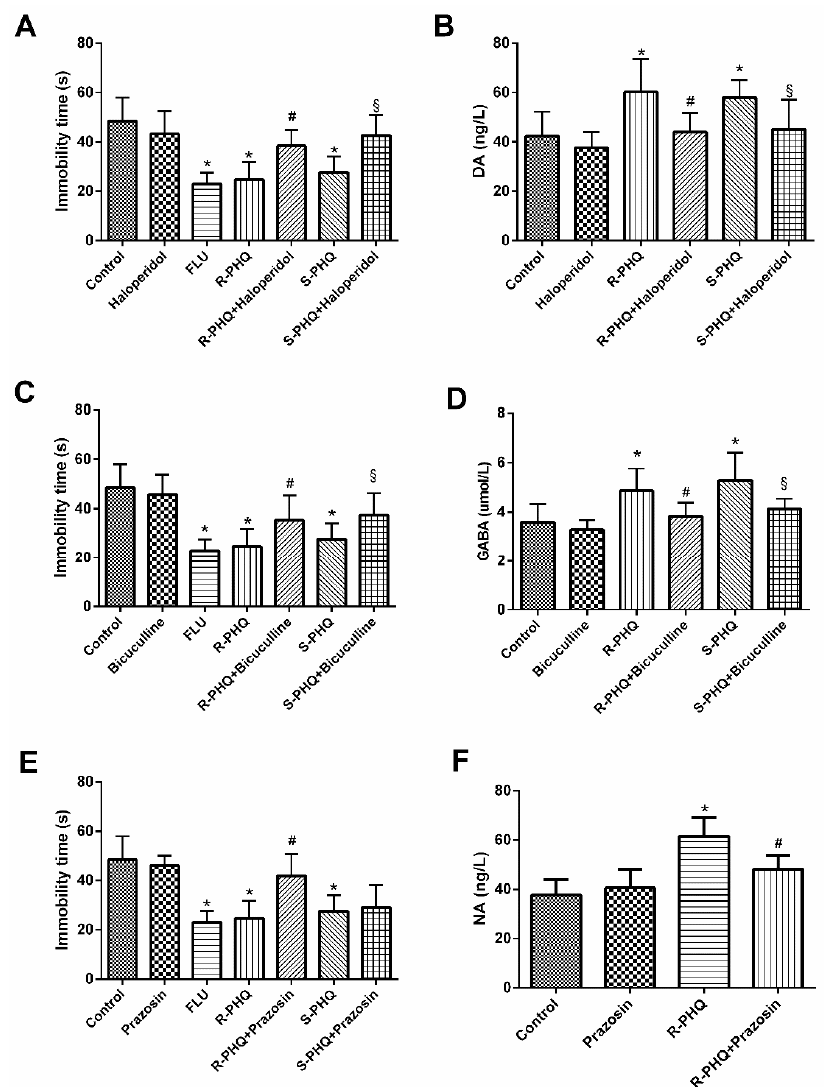
Figure 4. Effects of pretreatment with ( A ) haloperidol (0.2 mg/kg, intraperitoneally (i.p.)), ( C ) bicuculline (4.0 mg/kg), and ( E ) prazosin (1.0 mg/kg) on the antidepressant-like effect induced by R -PHQ and S -PHQ (30 mg/kg) in the FST; the values are represented as means ± SD ( n = 10). The effects of R -PHQ, S -PHQ, haloperidol, bicuculline, prazosin, and their co-treatment on the brain levels of ( B ) dopaminergic (DA), ( D ) γ -aminobutyric acid (GABA), and ( F ) noradrenergic (NA) systems; the values are represented as means ± SD ( n = 8); * p < 0.01 as compared to the control group; # p < 0.01 as compared to the R -PHQ-treated group; § p < 0.01 as compared to the S -PHQ-treated group.